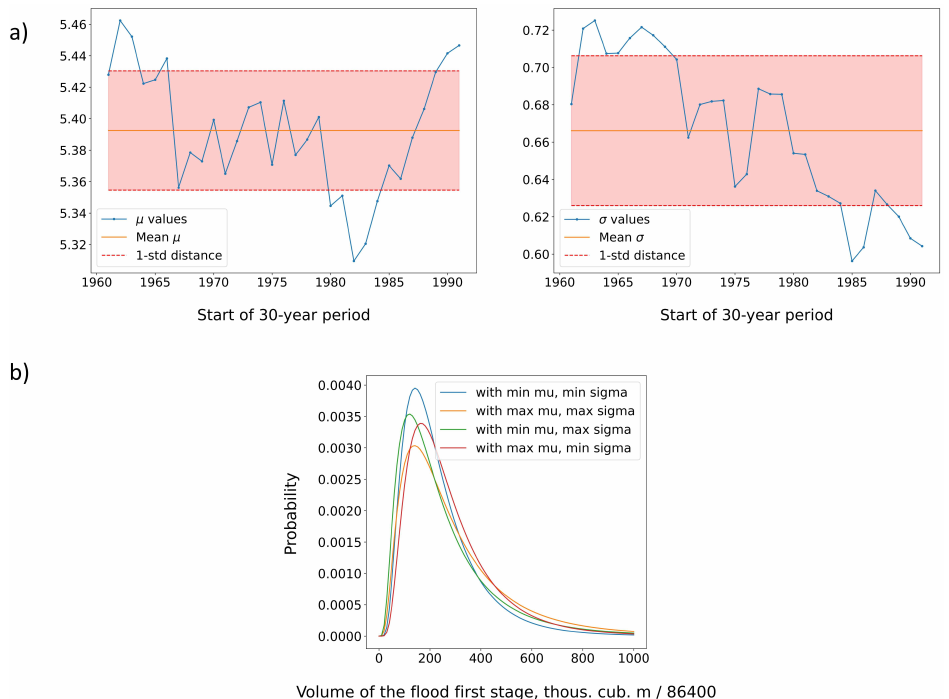
Figure 17. ( a ) Variability of the parameters of the lognormal distribution of the values of the relative volume of the flood hydrograph through the dam for different 30-year intervals. The color indicates the range of one standard deviation. ( b ) Limiting lognormal distributions of the actual volumes of flood hydrographs for 1962–2021.